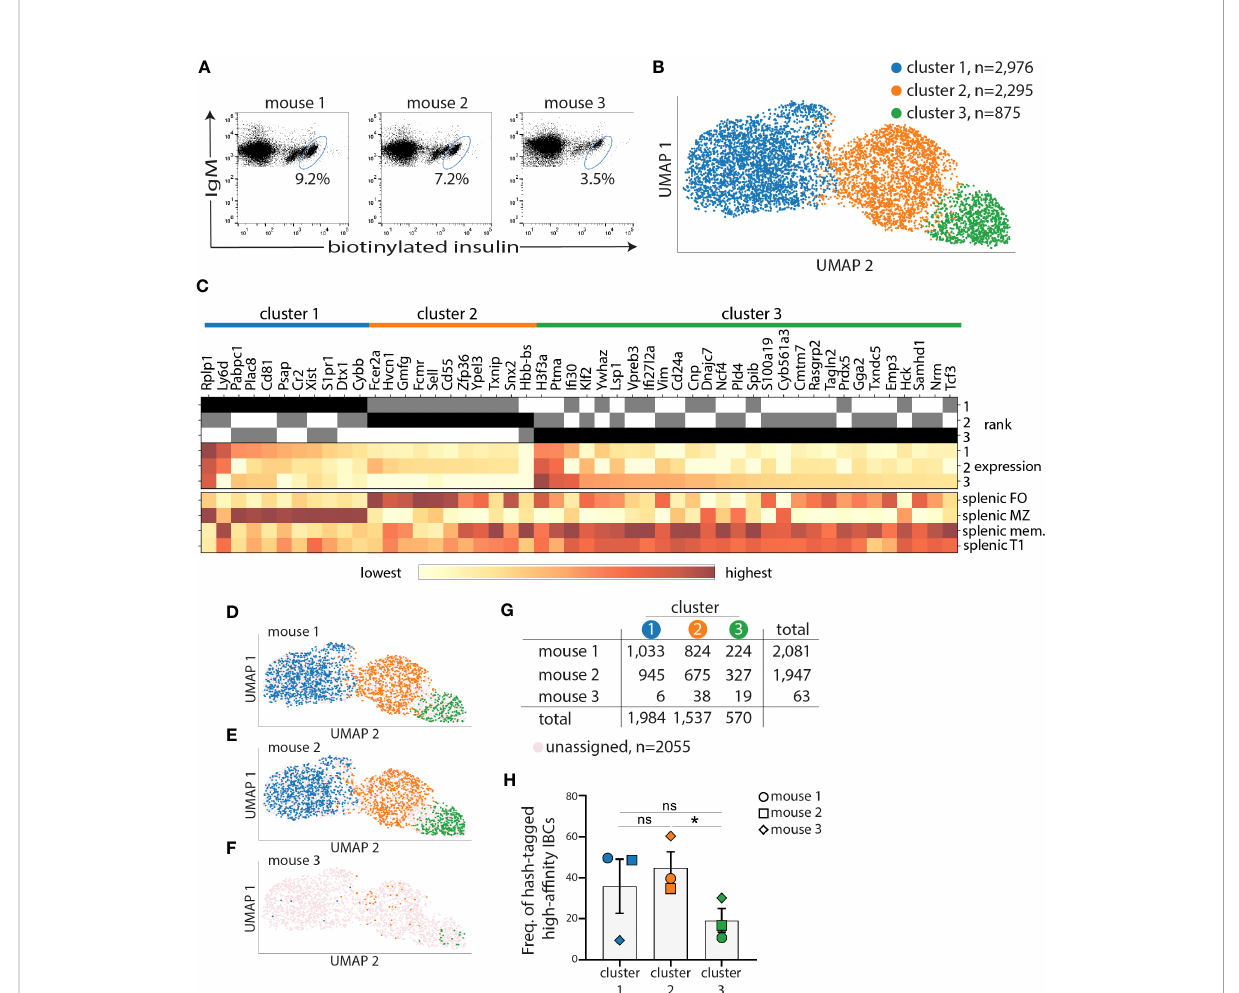
FIGURE 2 Marginal zone and follicular B-cell transcriptional clusters encompass most of high-af fi nity IBCs of VH125.NOD. Splenocytes from three prediabetic VH125.NOD were labeled with three different hashtag antibodies, cell sorted for high-af fi nity IBCs, pooled, and subjected to scRNA- seq on the 10X Genomics platform. (A) Flow panels representing sorted high-af fi nity IBCs (gated on lymphocytes/singlets/live cells/B220 + IgM + cells) from three prediabetic VH125.NOD mice. (B) Three clusters identi fi ed among high-af fi nity IBCs by unsupervised 10X CellRanger clustering method (blue – cluster 1, orange – cluster 2, green – cluster 3). (C) Heatmap of fi fty differentially expressed genes among clusters. High-af fi nity IBCs from each cluster and donor mouse, overlayed on UMAP (D – F) , with cell numbers for each cluster, including unassigned cells, (G) , and frequency (H) (each symbol represents the same mouse as in Figure 3: circle – mouse 1, square – mouse 2, diamond – mouse 3). One-way ANOVA, followed by post hoc Tukey ’ s multiple comparisons tests were used to determine the signi fi cance of differences among groups. *P < 0.05, ns, no statistical signi fi